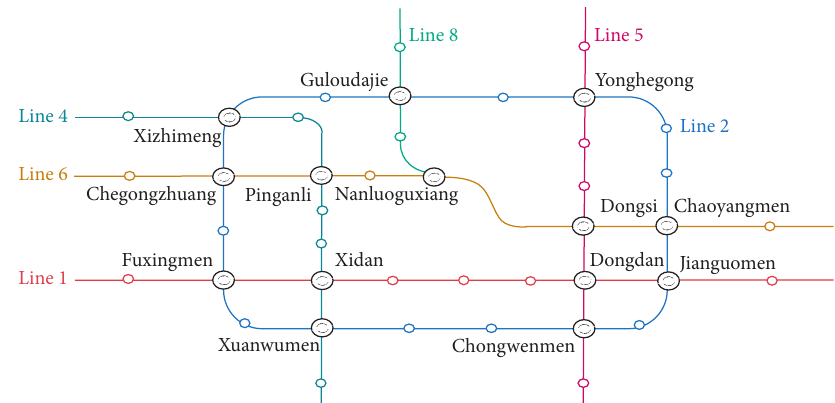
Figure 5: Topology map of the Beijing